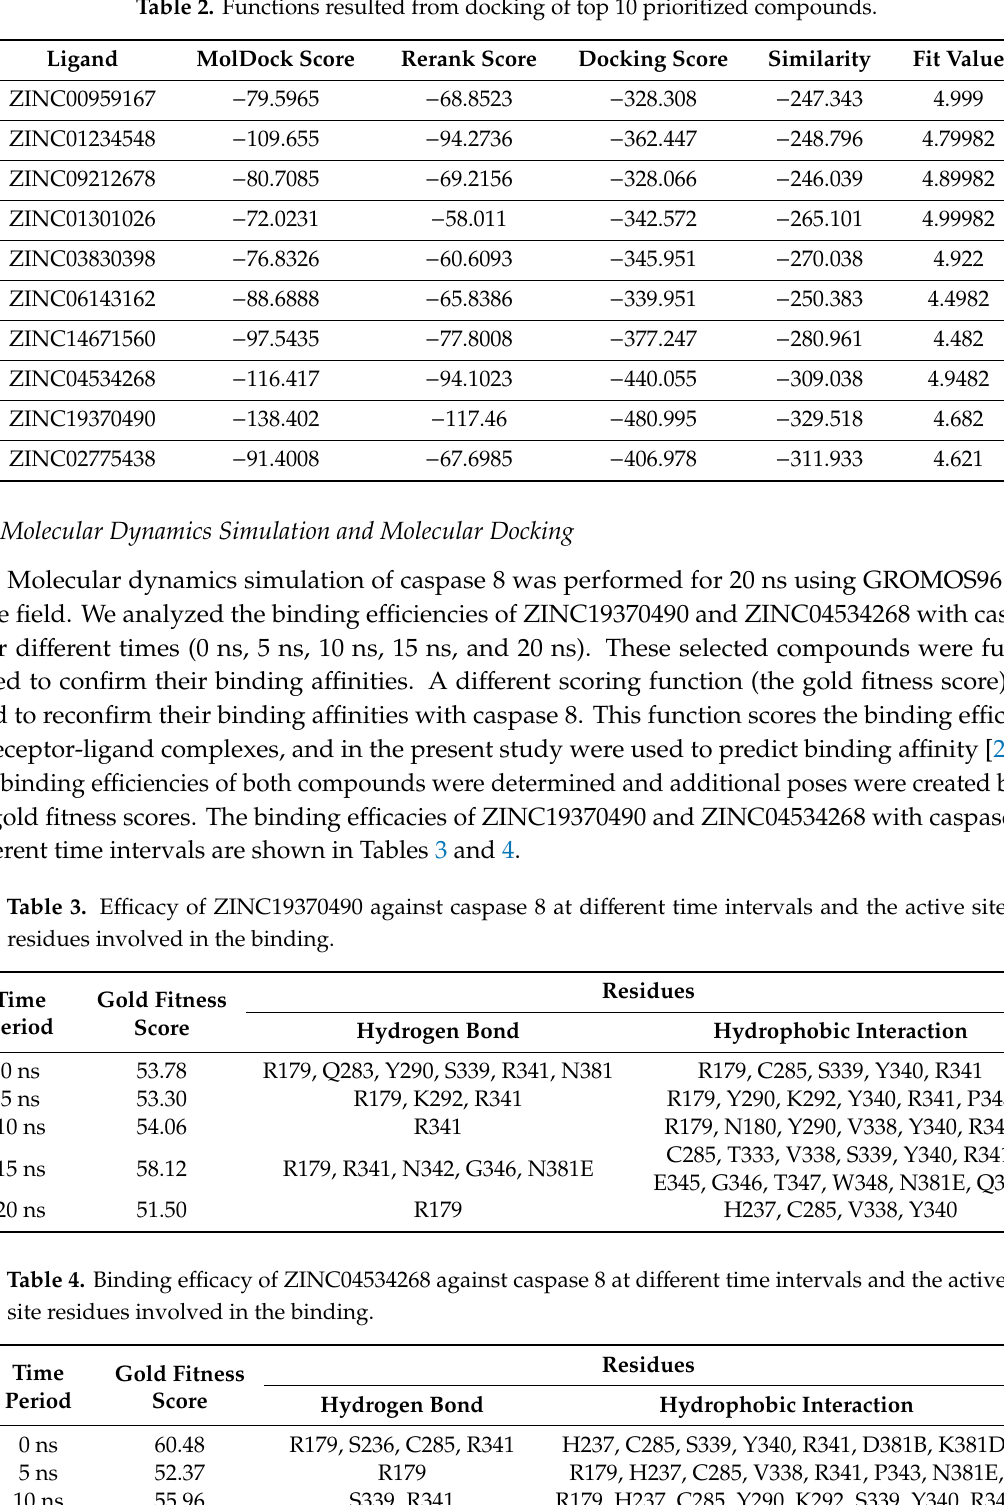
Table 2. Functions resulted from docking of top 10 prioritized compounds.